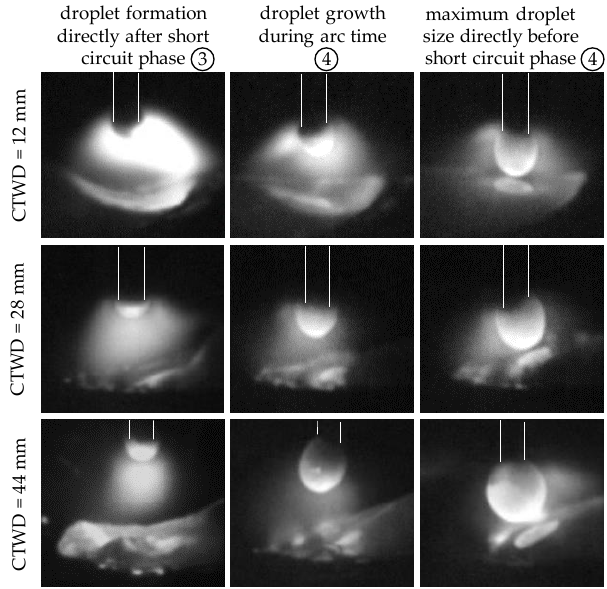
Figure 6. Droplet formation during GMAW with increasing CTWD for U = 20 V; v wire = 5 m/min and v weld = 0.4 m/min.